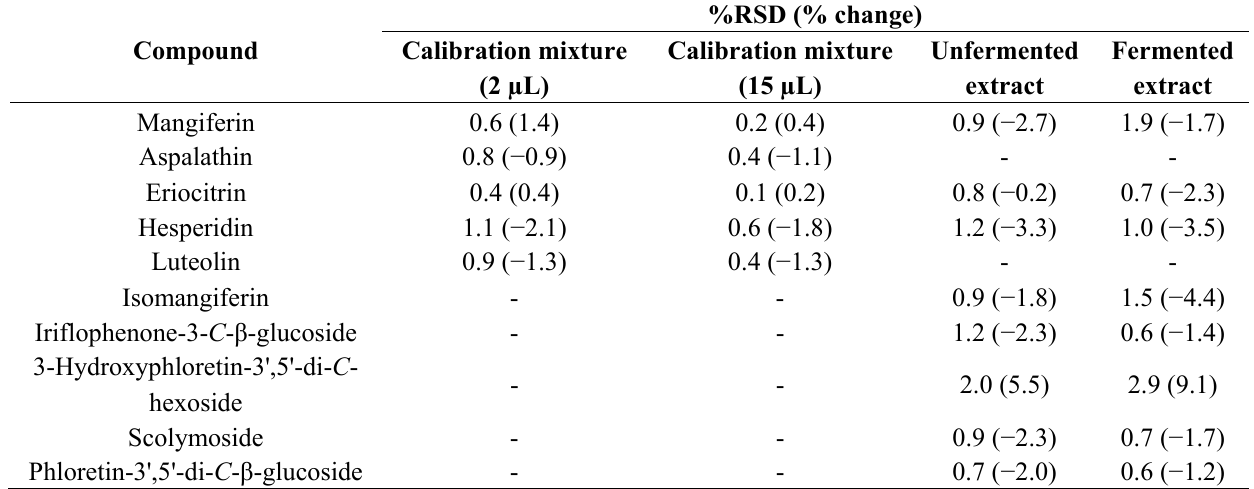
Table 4. Compound stability in standard calibration mixtures and freeze-dried aqueous extracts of green and fermented Cyclopia subternata over a